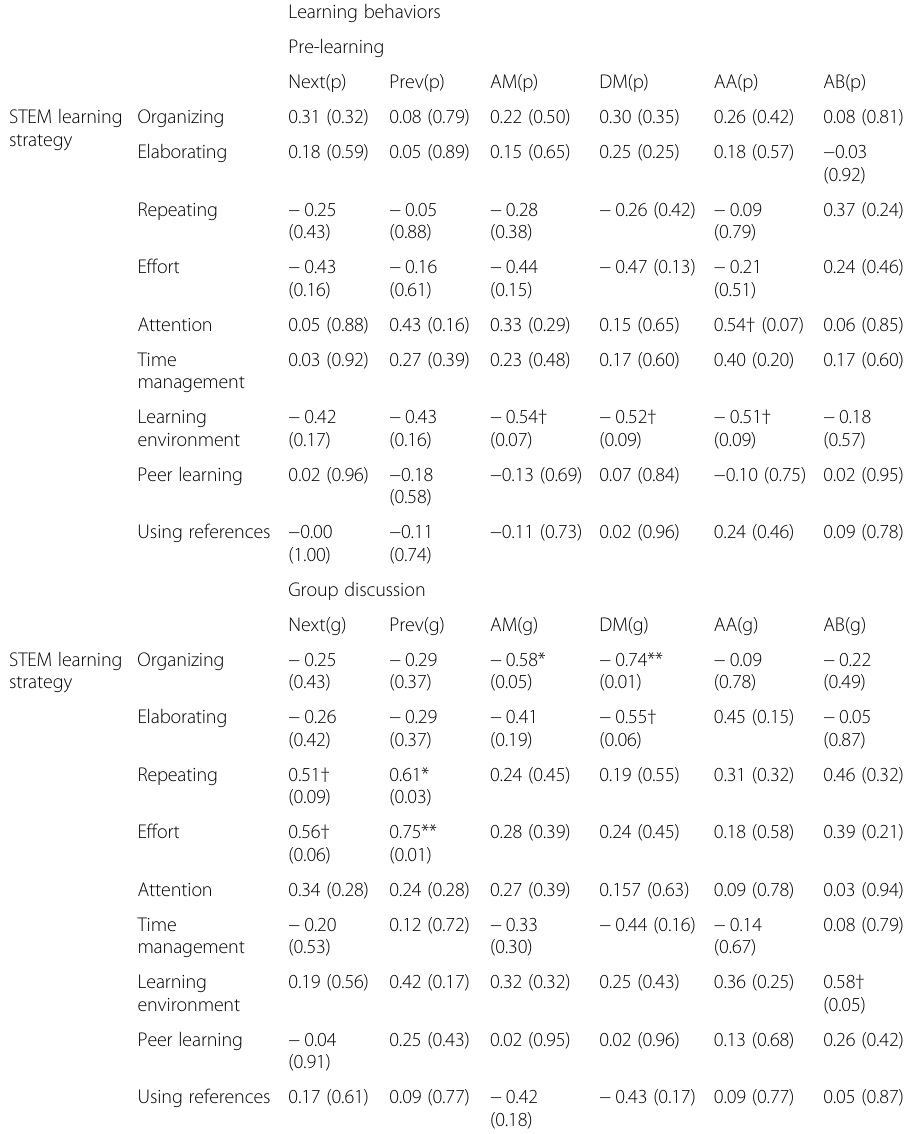
Table 8 Spearman ’ s rank correlation coefficients between STEM learning strategy and learning